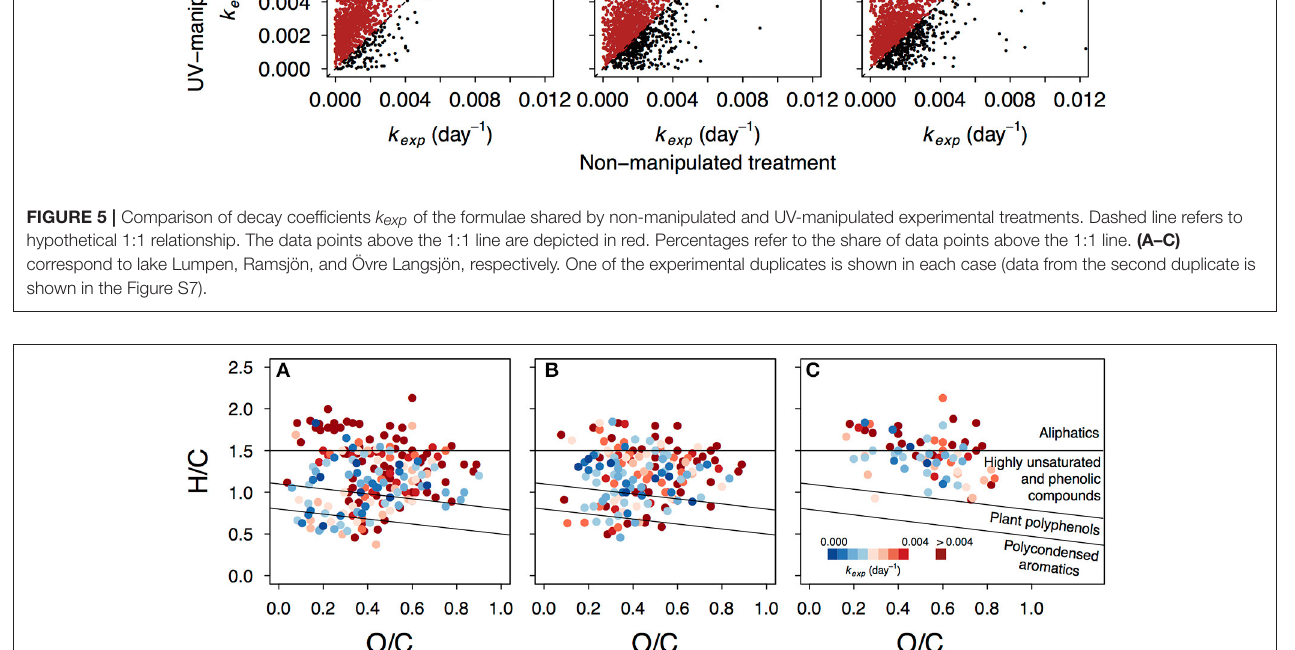
Frontiers in Earth Science |